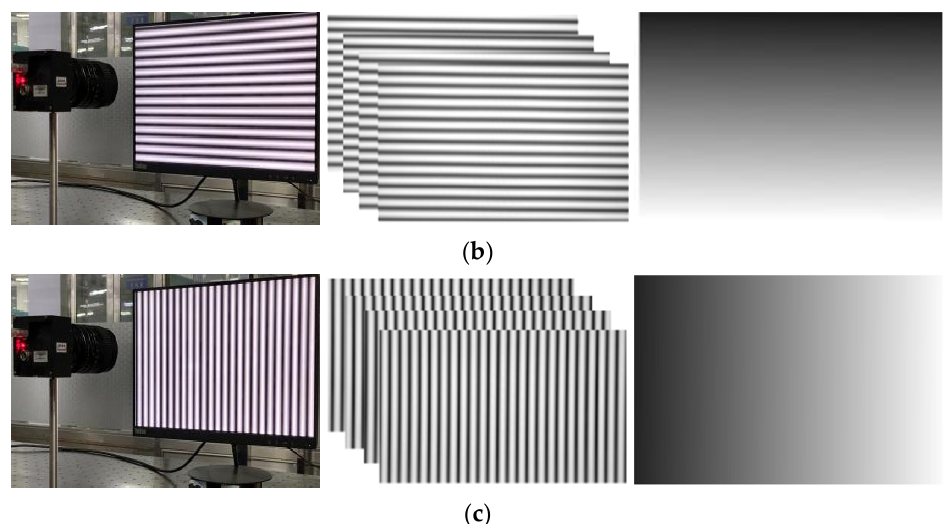
Figure 11. ( a ) Schematic diagram of experimental device; ( b ) the camera captures the horizontal stripes of the LCD display and phase map; ( c ) the camera captures the vertical stripes of the LCD display and phase map.